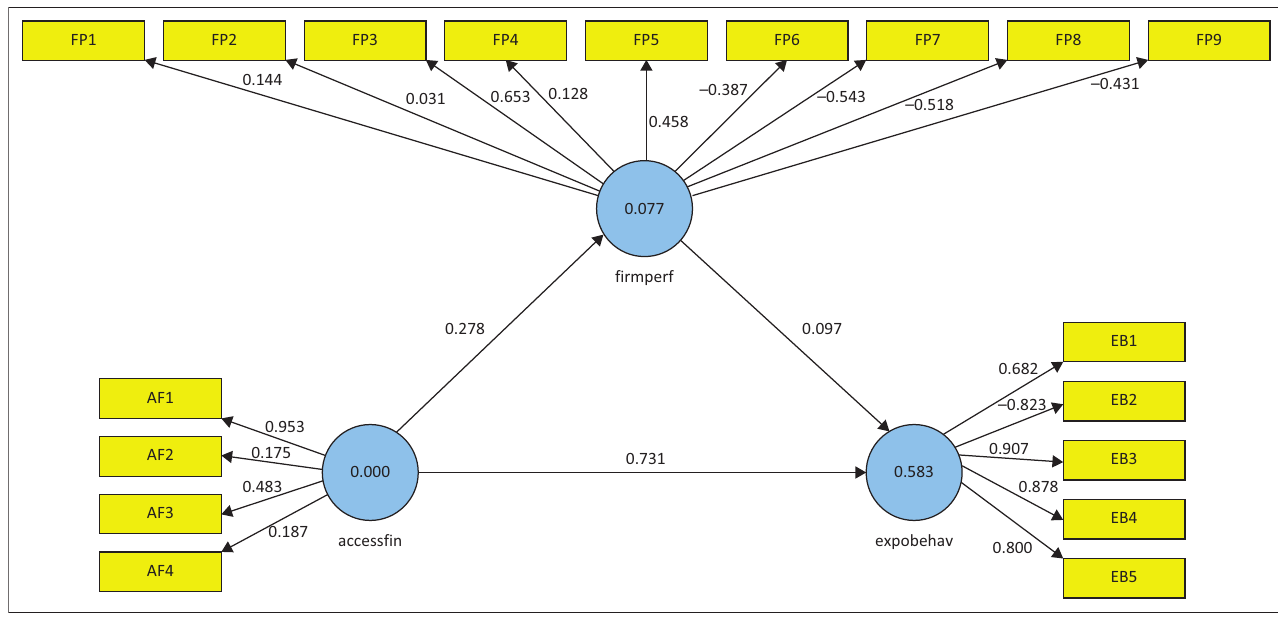
FIGURE 2: Measurement and structural model results.